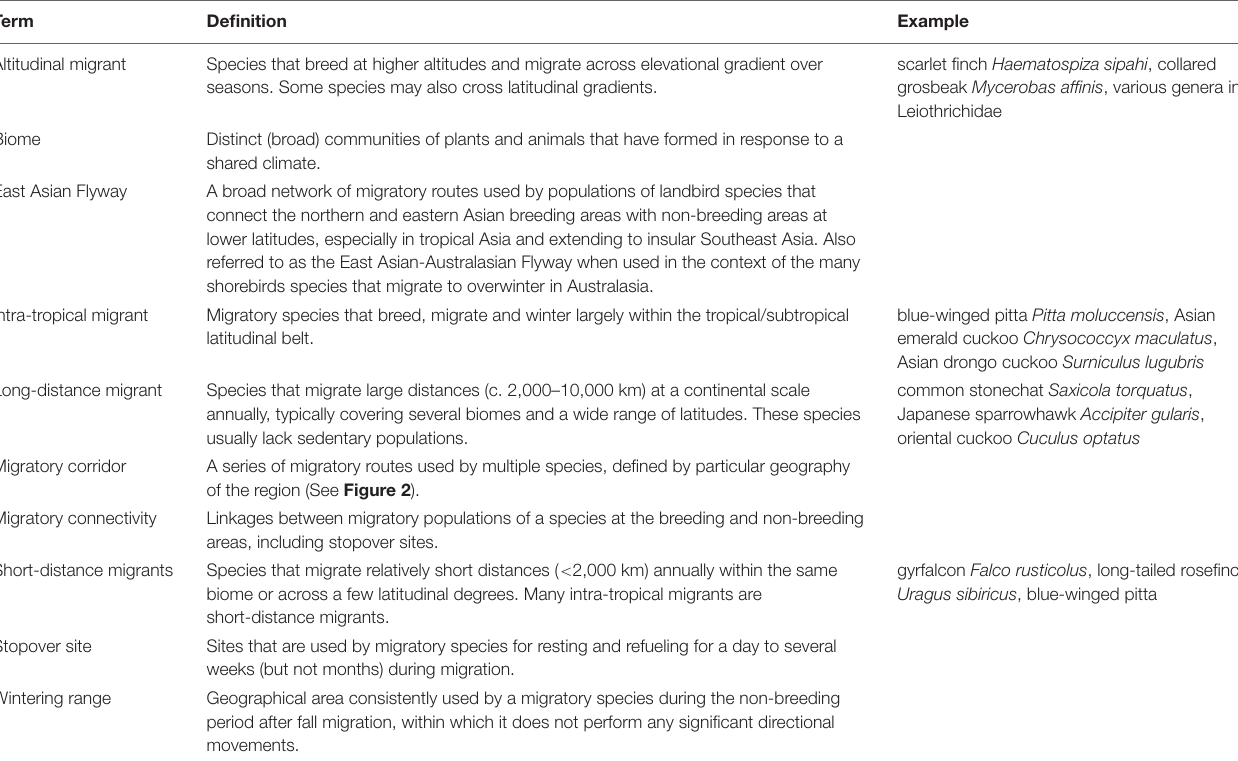
TABLE 1 | Definitions of key terms mentioned in the text.